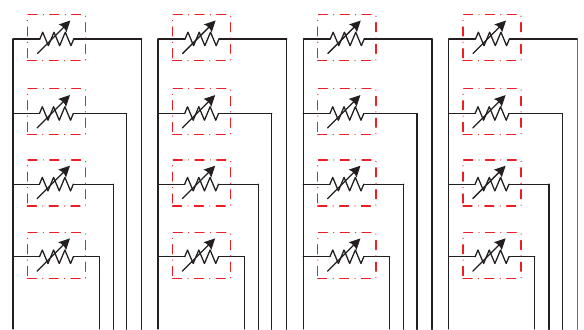
Figure 6. Circuit model of the electronic